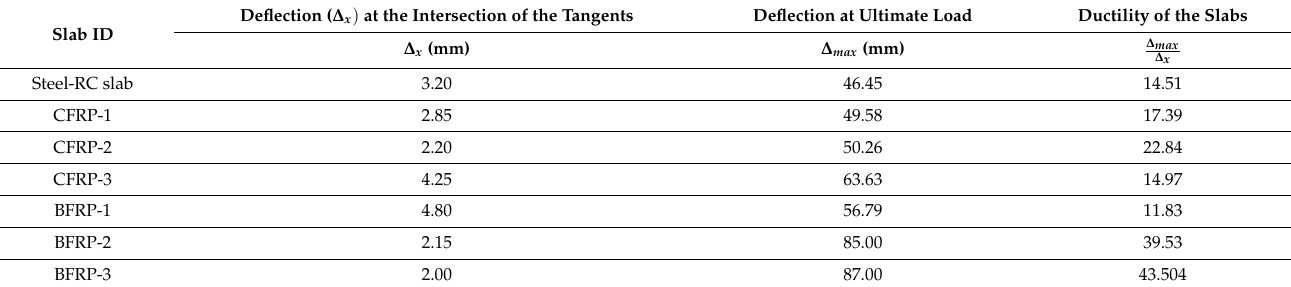
Table 5. Displacement ductility of the slabs investigated.